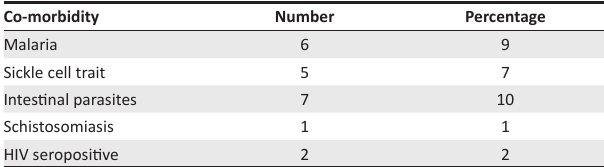
FIGURE 1: Changes in triceps skinfold and mid-upper arm circumference. TABLE 2: Co-morbidities on admission in 70 patients.